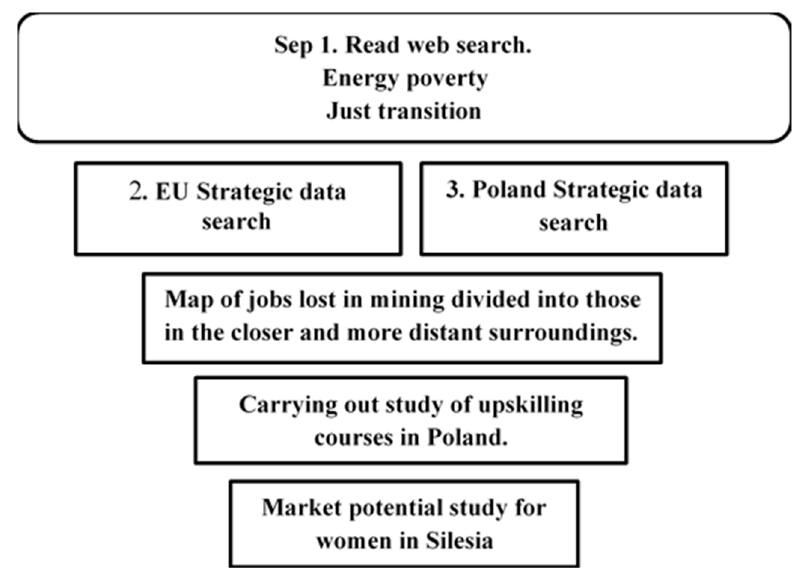
Figure 1. Algorithm for recognizing the market potential for Silesian women developed in this study.